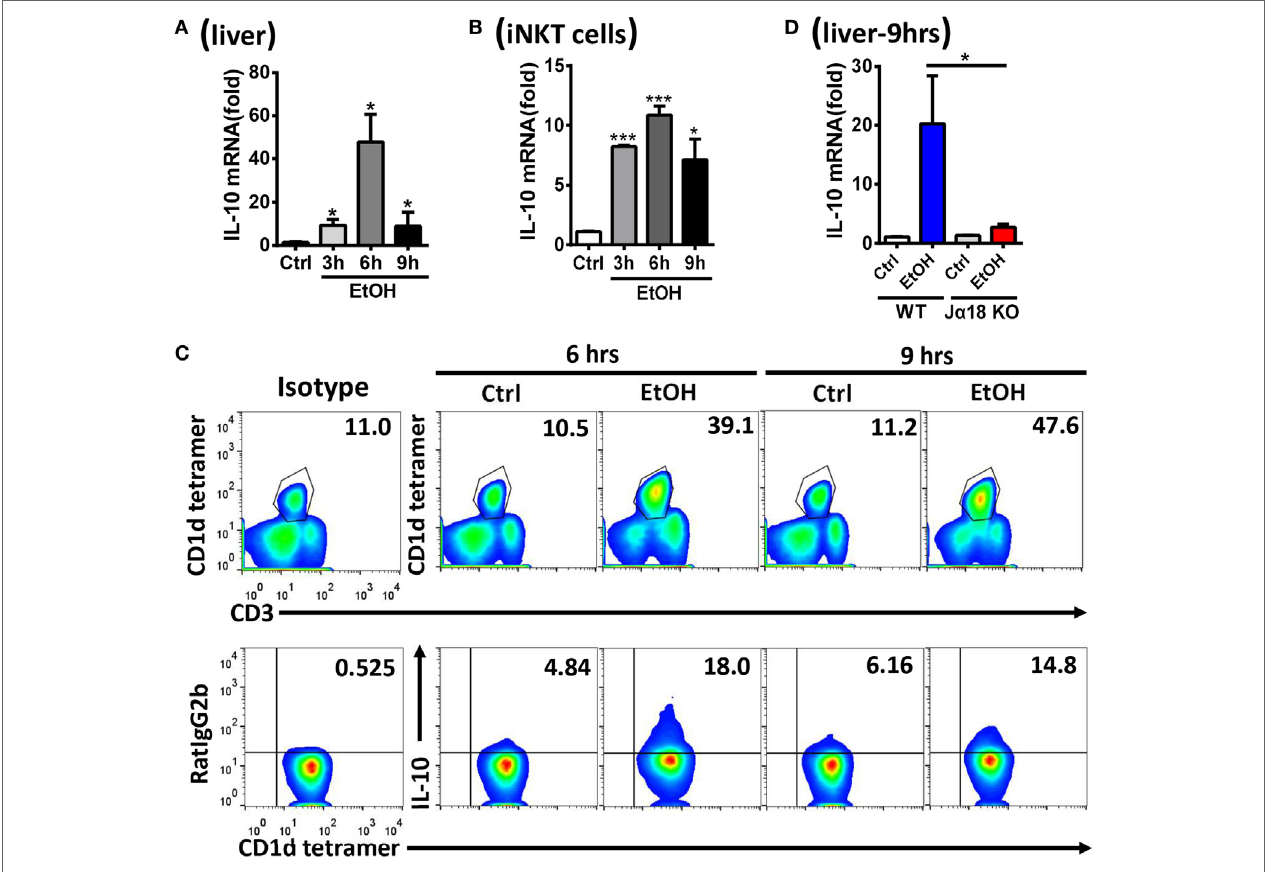
FigUre 9 | Hepatic invariant natural killer T (iNKT)-derived interleukin-10 (IL-10) was markedly increased after alcohol challenge. (a–c) C57BL/6 mice were fed control or ethanol diets for 10 days plus one intragastric dose of EtOH (5 g/kg body weight) or isocaloric dextran-maltose, followed by euthanasia 3, 6, or 9 h after gavage. The mRNA levels of IL-10 in (a) liver tissues and (B) purified hepatic iNKT cells were evaluated by quantitative PCR (q-PCR). (c) Liver mononuclear cells were isolated, and the frequency of CD3 + CD1d tetramer + iNKT cells among all leukocytes in the liver and the release of IL-10 by iNKT cells were analyzed by flow cytometry. (D) Wild-type or J α 18 − / − mice were fed control or ethanol diets for 10 days, followed by gavage as described in Figure 3 . The mice were euthanized 9 h after gavage, and the mRNA levels of IL-10 in liver tissues were detected by q-PCR. The data are representative of two independent experiments and are shown as the mean ± SEM ( n = 4). * P < 0.05; *** P <